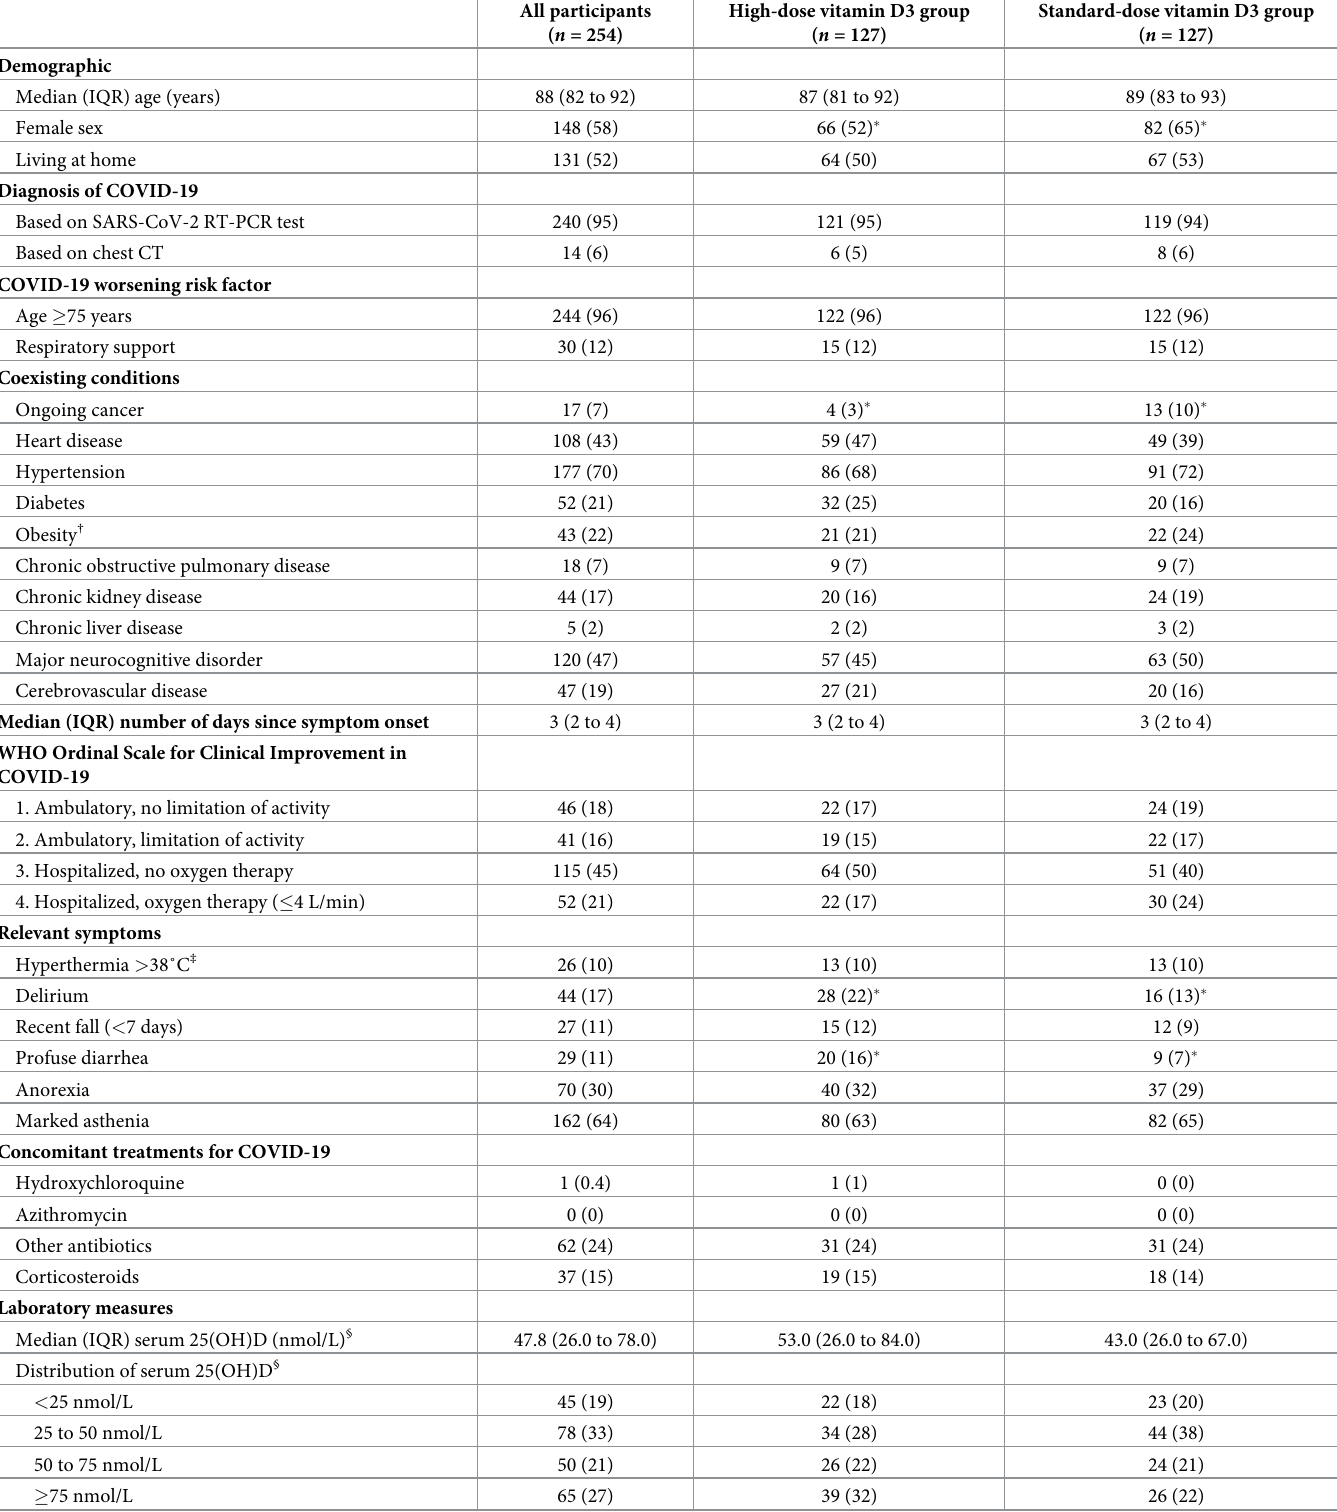
Table 1. Baseline